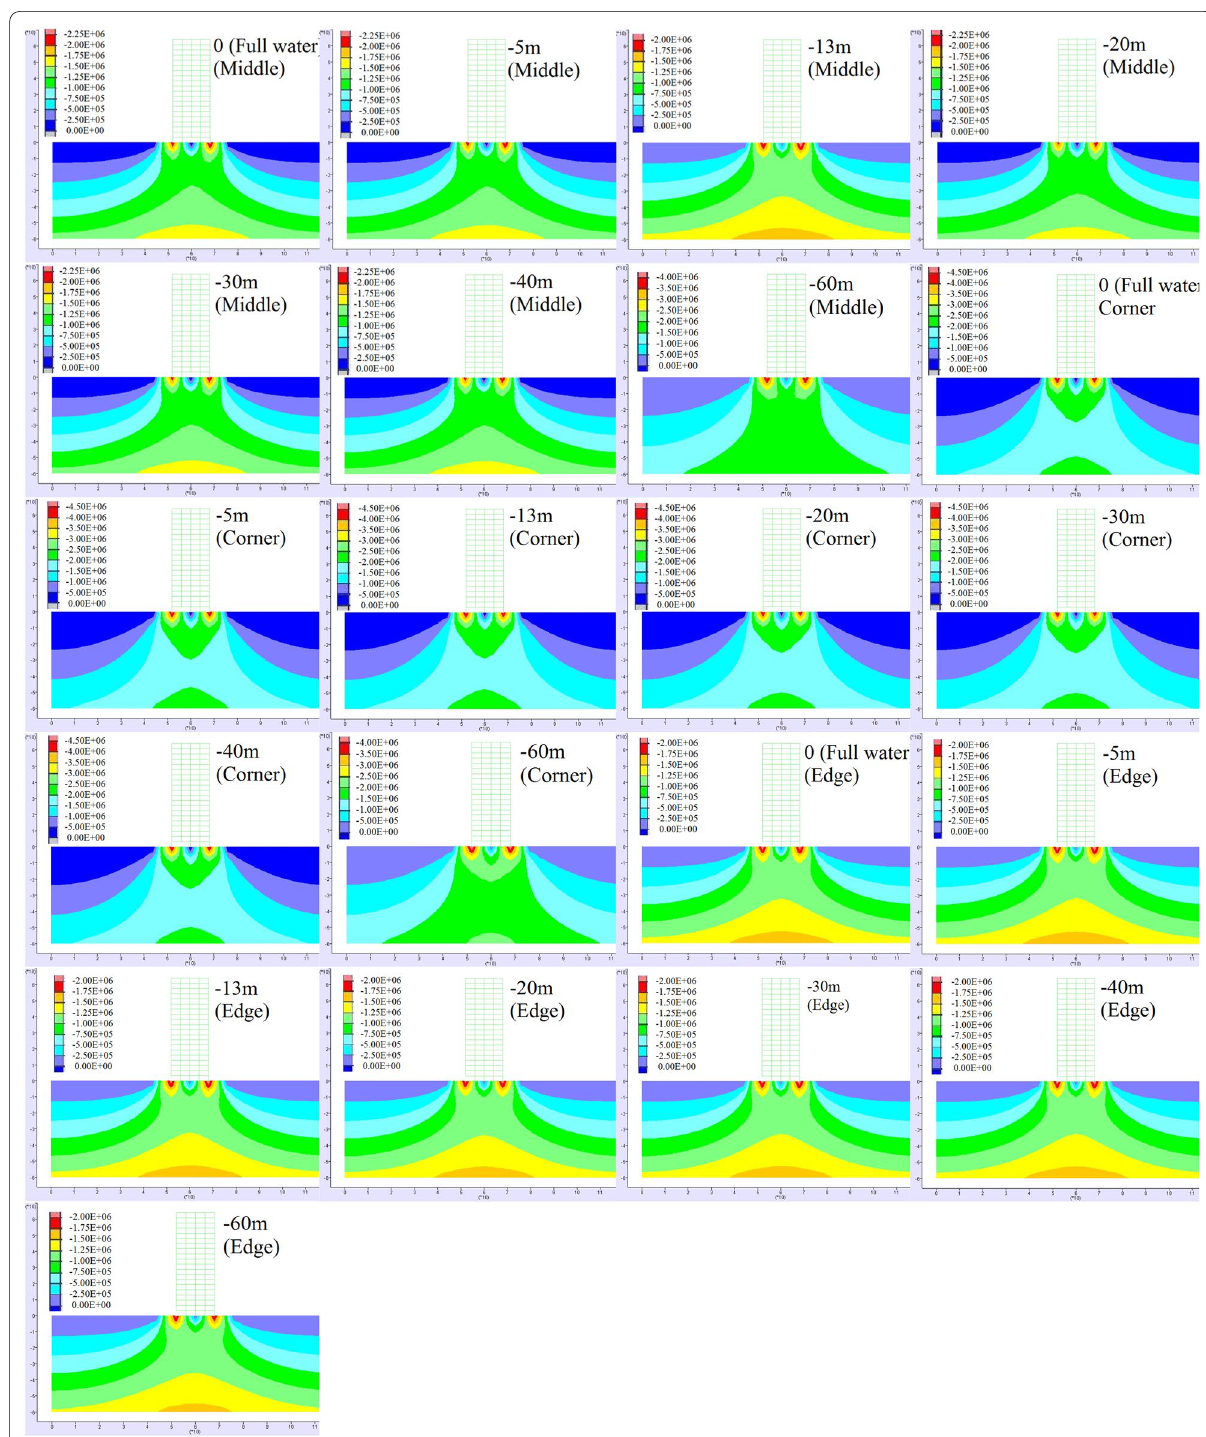
Fig. 18 SYY contours of the frames with column removal with different levels of